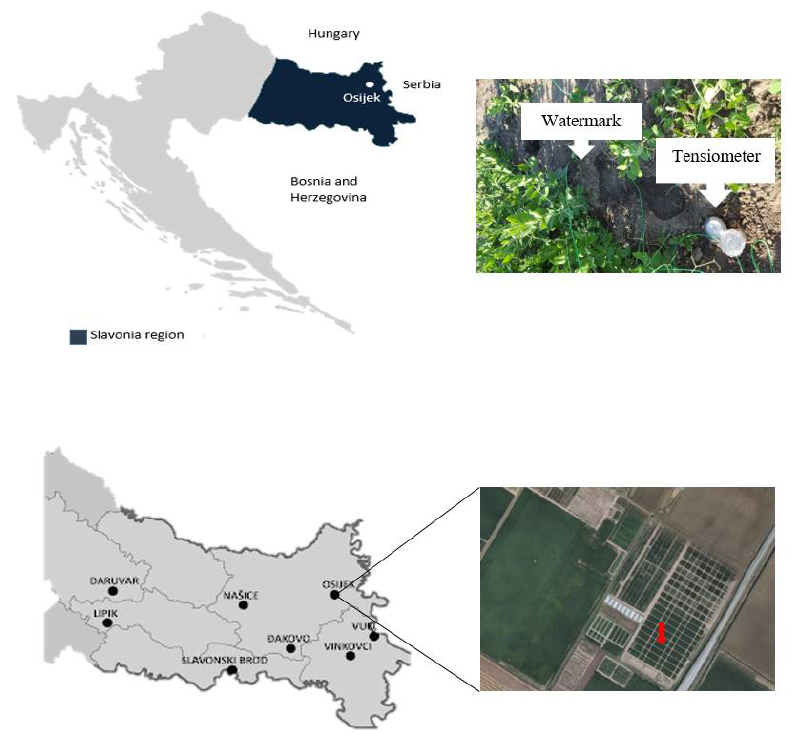
Figure 1. Map of the study area and